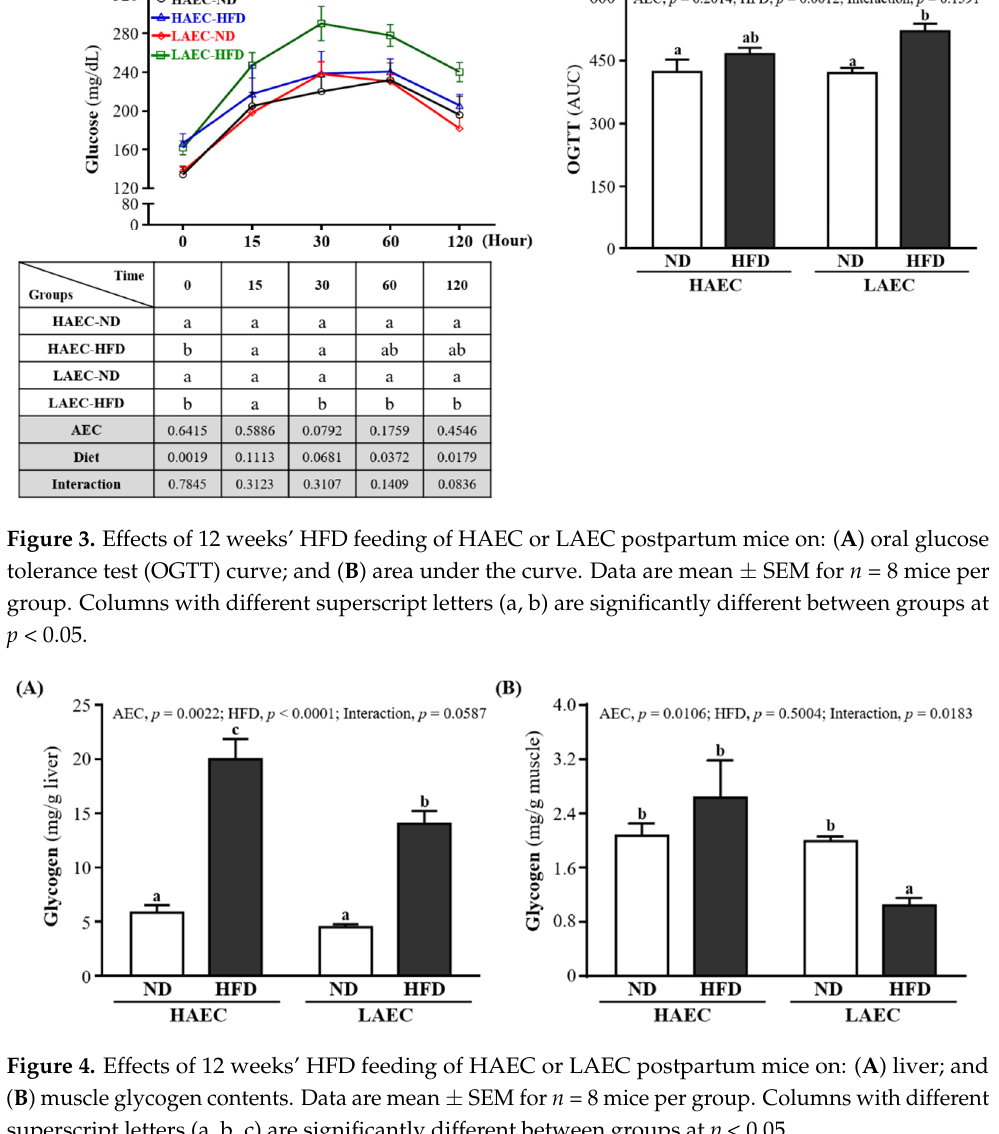
Figure 4. Effects of 12 weeks’ HFD feeding of HAEC or LAEC postpartum mice on: ( A ) liver; and ( B ) muscle glycogen contents. Data are mean ± SEM for n = 8 mice per group. Columns with different superscript letters (a, b, c) are significantly different between groups at p < 0.05.